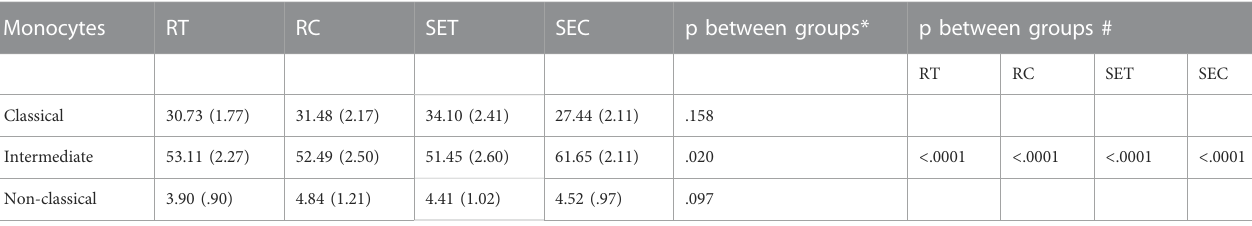
TABLE 7 Percentage of monocyte subtypes, according to the treatment arms. Monocytes RT RC SET SEC